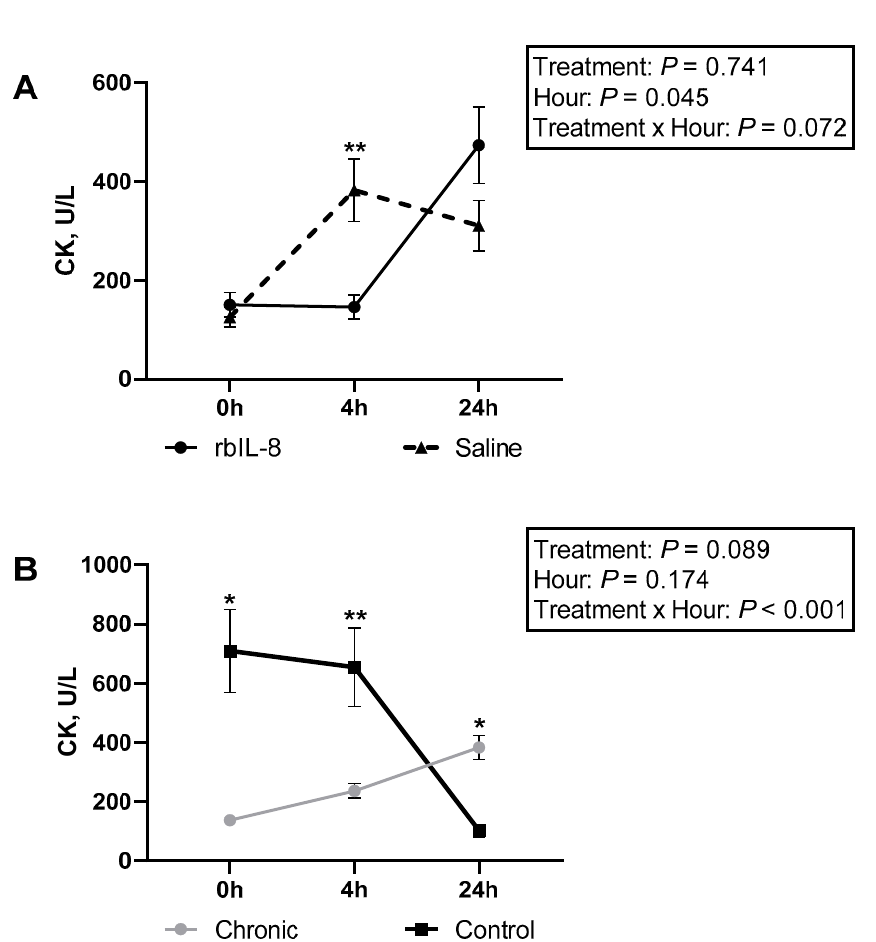
Table 3. Biochemical profile among groups and hours relative to treatment.